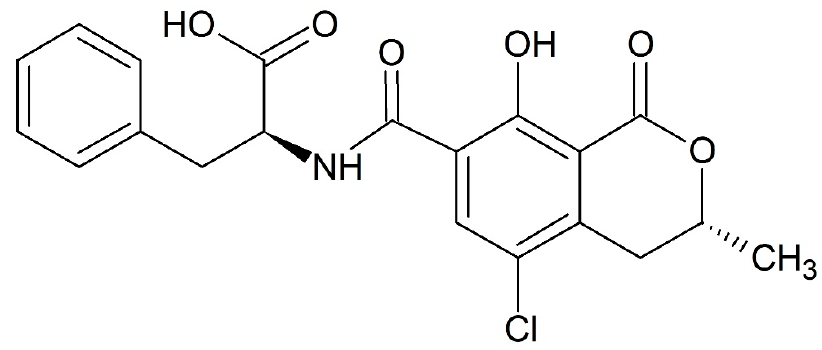
Figure 1. Chemical structure of Ochratoxin A.